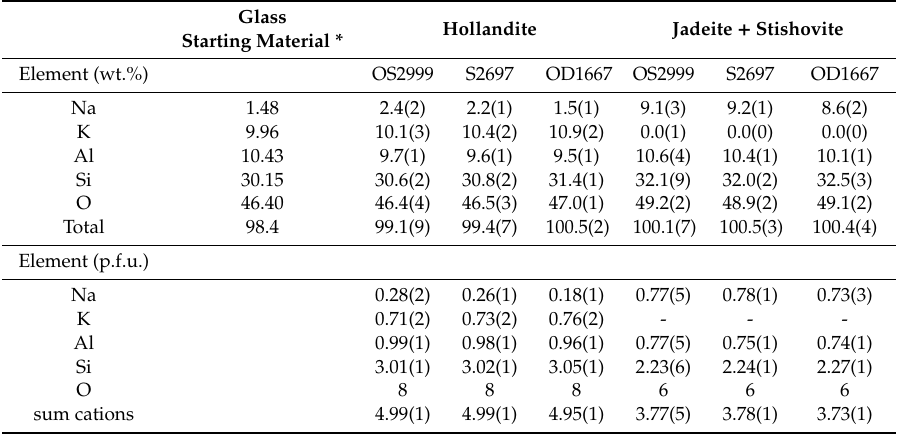
Table 2. Composition of starting material and run products.